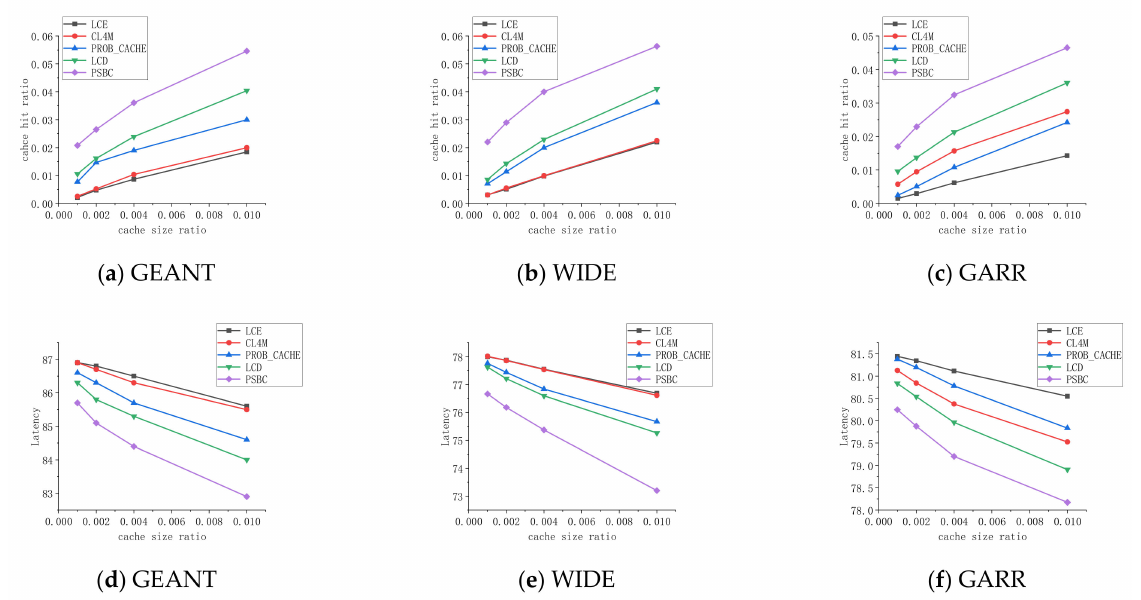
Figure 5. Cache performance with different cache size